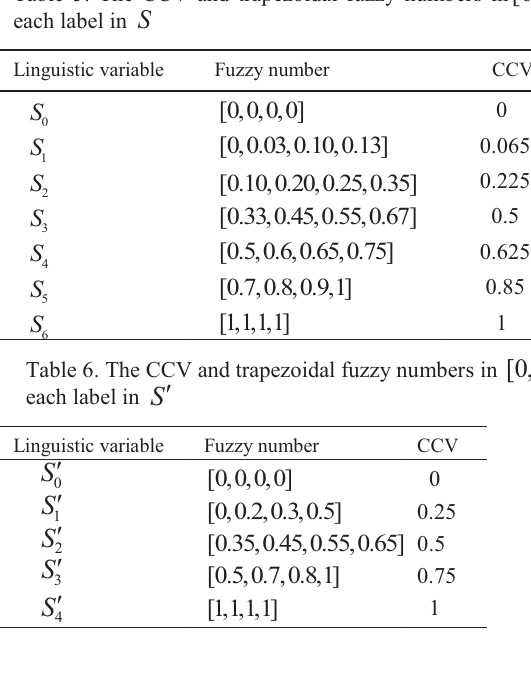
Table 5. The CCV and trapezoidal fuzzy numbers in [0,1] of